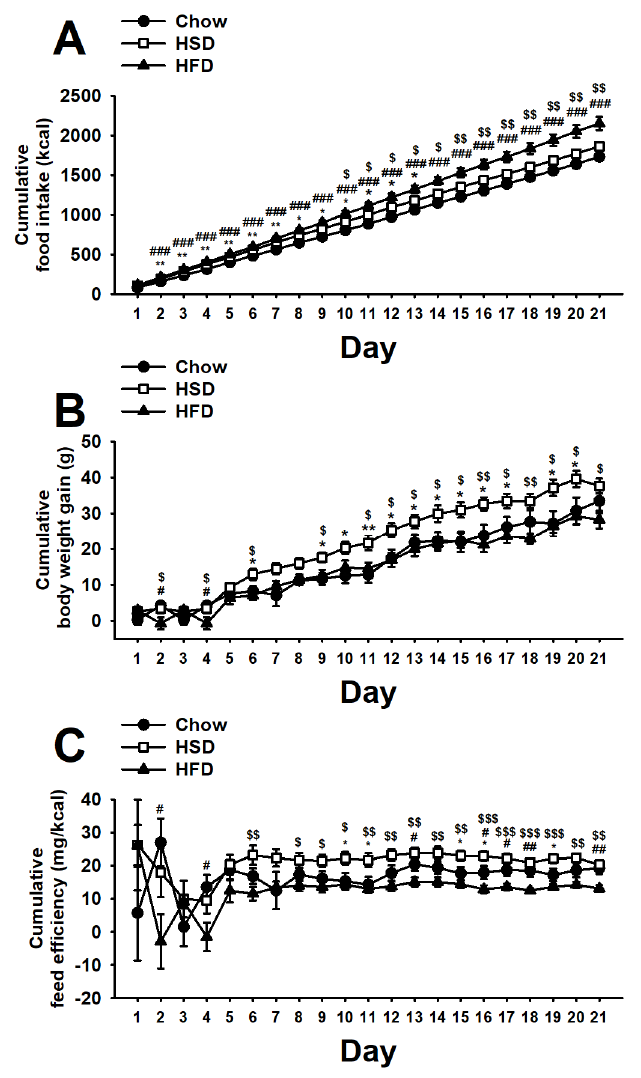
Figure 6. Effects of daily 1-h operant self-administration of Chow, HSD, or HFD on ( A ) cumulative food intake (kcal), ( B ) cumulative body weight gain (g), and ( C ) cumulative feed efficiency (mg/kcal) in female Sprague Dawley rats ( n = 10/group). Rats were given the chance to self-administer one of the three diets in a fixed ratio 1 schedule during a 21-day period. Chow was otherwise freely available in the home cages. Panels represent M ± SEM. Symbols denote the following: * HSD differs from Chow, p < 0.05, ** p < 0.01; # HFD di ff ers from Chow, p < 0.05, ## p < 0.01, ### p < 0.001; $ HSD di ff ers from HFD, p < 0.05, $$ p < 0.01, $$$ p < 0.001 (Newman–Keuls